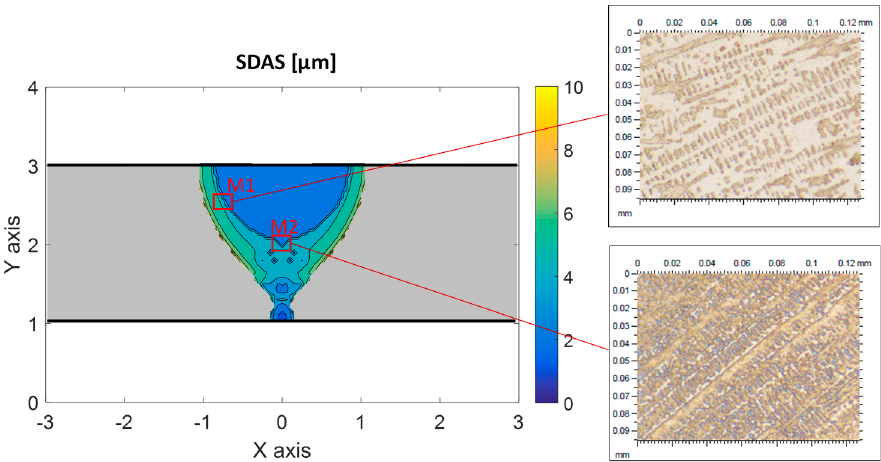
Figure 12. Simulated secondary dendrite arm spacing (SDAS) for cross section and experimental microstructure details in regions M1 and M2 of Test 8 (500 W and 5 mm·s − 1 ).